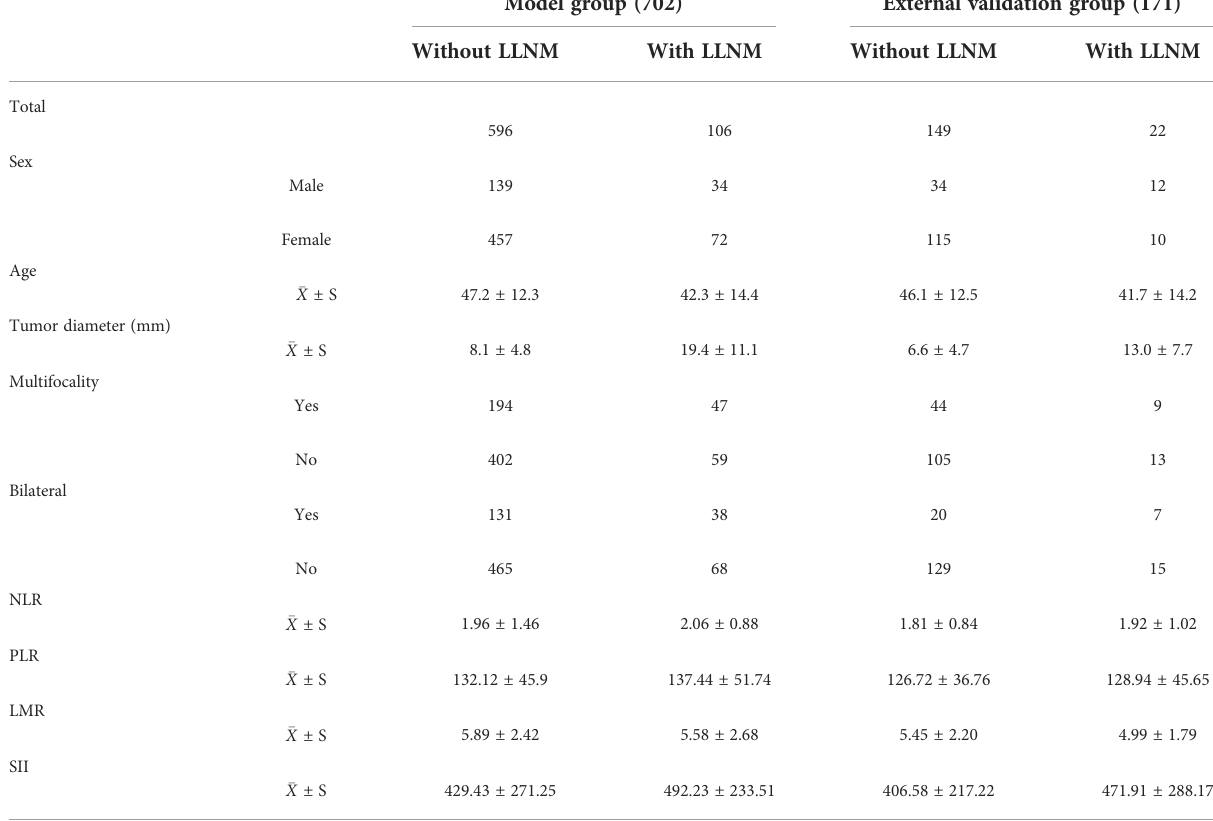
TABLE 1 General information of papillary thyroid carcinoma patients in model and external validation